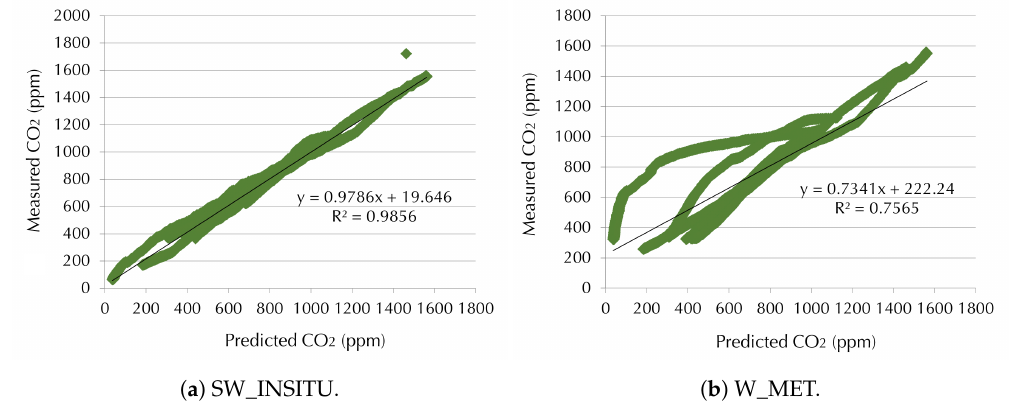
Figure 11. Correlation between predicted and measured CO 2 concentration by ELA models with SW_INSITU and W_MET in P_1_T.